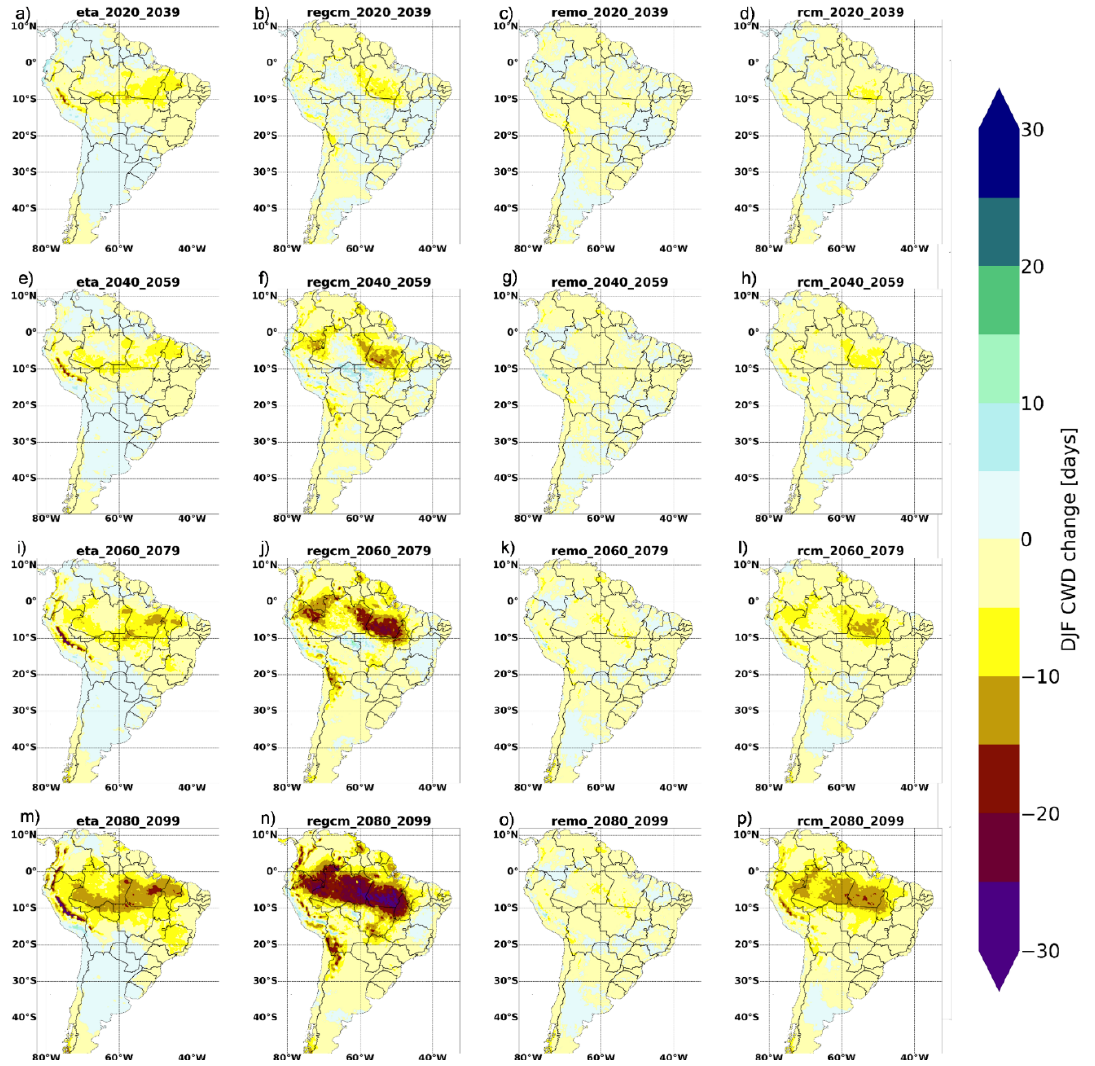
Figure 8. Changes projected to CWD (days) during austral summer computed from each RCM ensemble (Eta, RegCM, and REMO) and 3RCMs ensemble (right column) and considering four time-slices: ( a – d ) 2020–2039, ( e – h ) 2040–2059, ( i – l ) 2060–2079, and ( m – p )